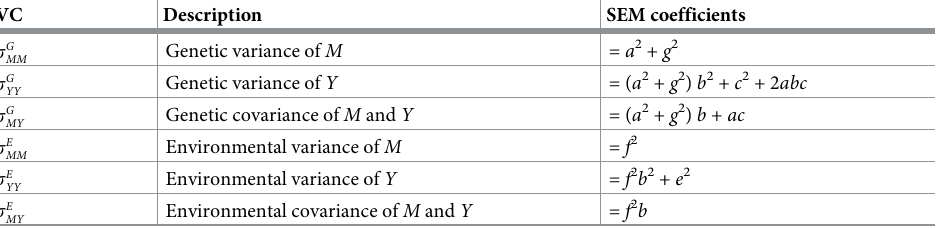
Table 1. Variance components (VCs) of mediator M and outcome Y as function of the coefficients in the structural equation model (SEM) shown in Fig 1. VC Description SEM coefficients Genetic variance of M = a 2 + g 2 s G MM Genetic variance of Y = ( a 2 + g 2 ) b 2 + c 2 + 2 abc s G YY Genetic covariance of M and Y = ( a 2 + g 2 ) b + ac s G MY Environmental variance of M = f 2 s E MM s E Environmental variance of Y = f 2 b 2 + e 2 YY s E Environmental covariance of M and Y = f 2 MY